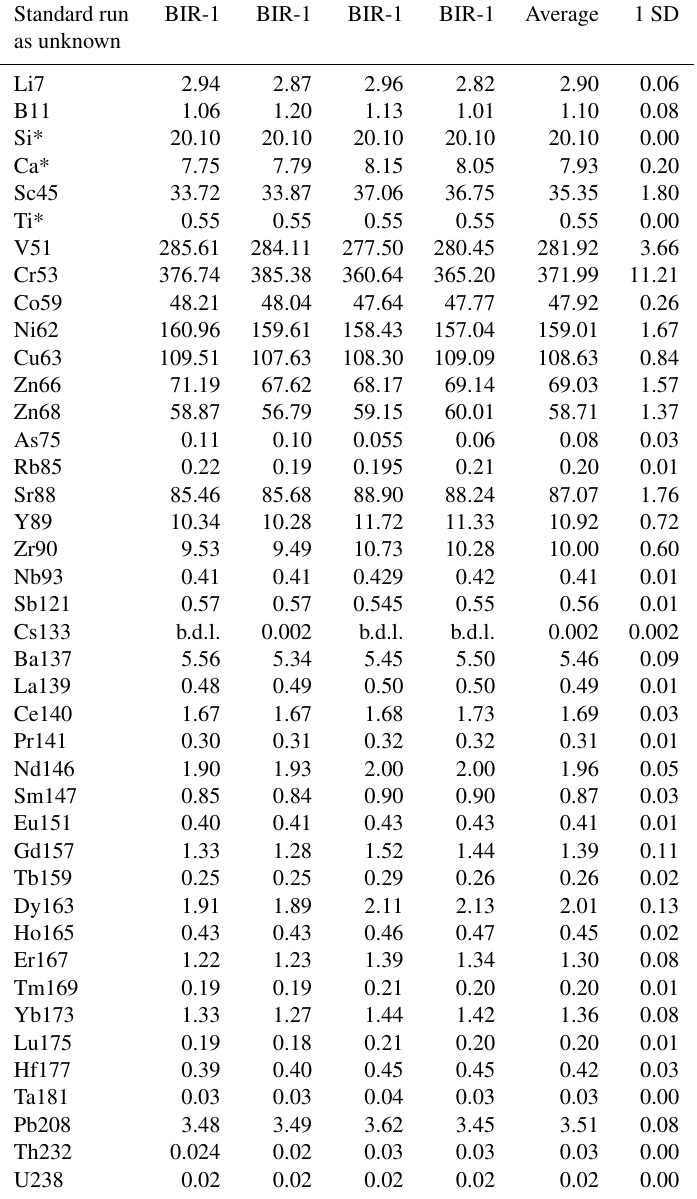
Table A1. Trace-element composition of USGS reference basalt BIR-1 repeatedly measured by HR-LA-ICPMS at the beginning and the end of the analytical session (all elements are in ppm, except Si*, Ca*, and Ti* in